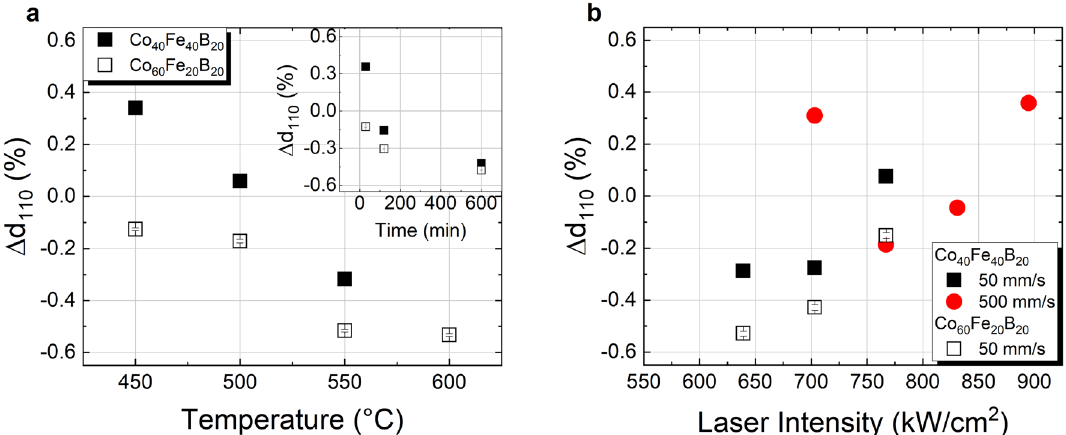
Figure 4. Comparison of CoFe(110) d-spacing deviation from database values for Co 40 Fe 40 B 20 and Co 60 Fe 20 B 20 (both with Ta cap) annealed ( a ) in the furnace for 30 min at temperatures of 400 °C–600 °C and at 450 °C at different times (inset), and ( b ) annealed by cw laser irradiation at different scanning speeds and laser intensities.